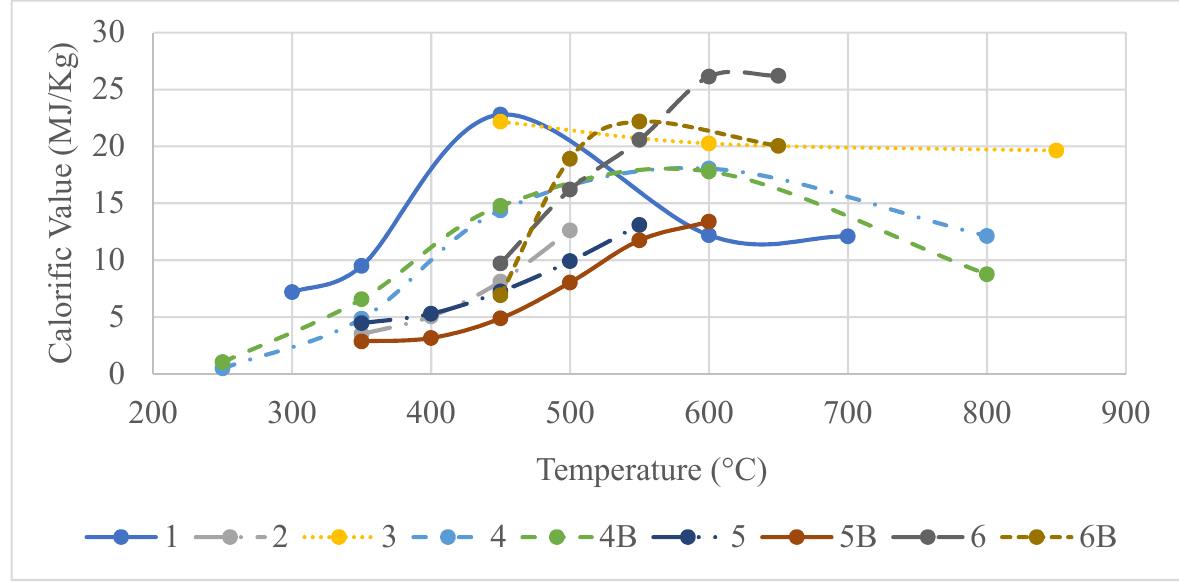
Figure 4. Effects of pyrolysis temperature on the calorific value (HHV) of the syngas: (1) Human faeces [52], (2) Sewage sludge [87], (3) Sewage sludge [43], (4 and 4B) Sewage sludge at 60 and 5 °C/min [88], (5 and 5B) Rice husk and corn stalk [83], (6 and 6B) Dried sewage sludge at 100 and 5 °C/min [89].